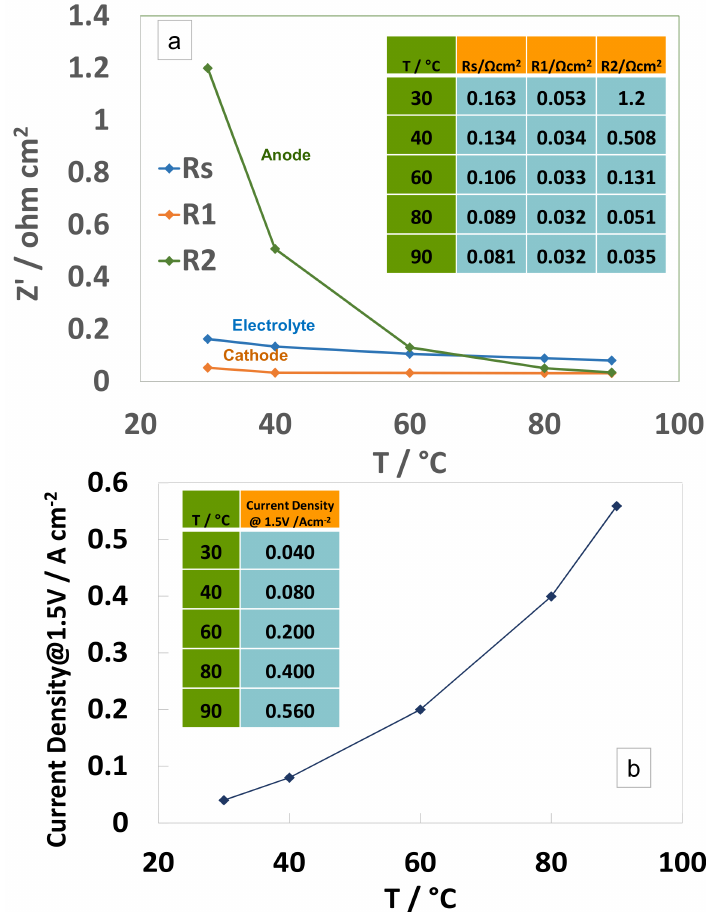
Figure 6. Variation of relevant electrochemical parameters at 1.5 V as a function of temperature for the medium catalyst loading (1.6 mg cm − 2 MEA )-based MEA. ( a ) R s refers to the series resistance; R1 and